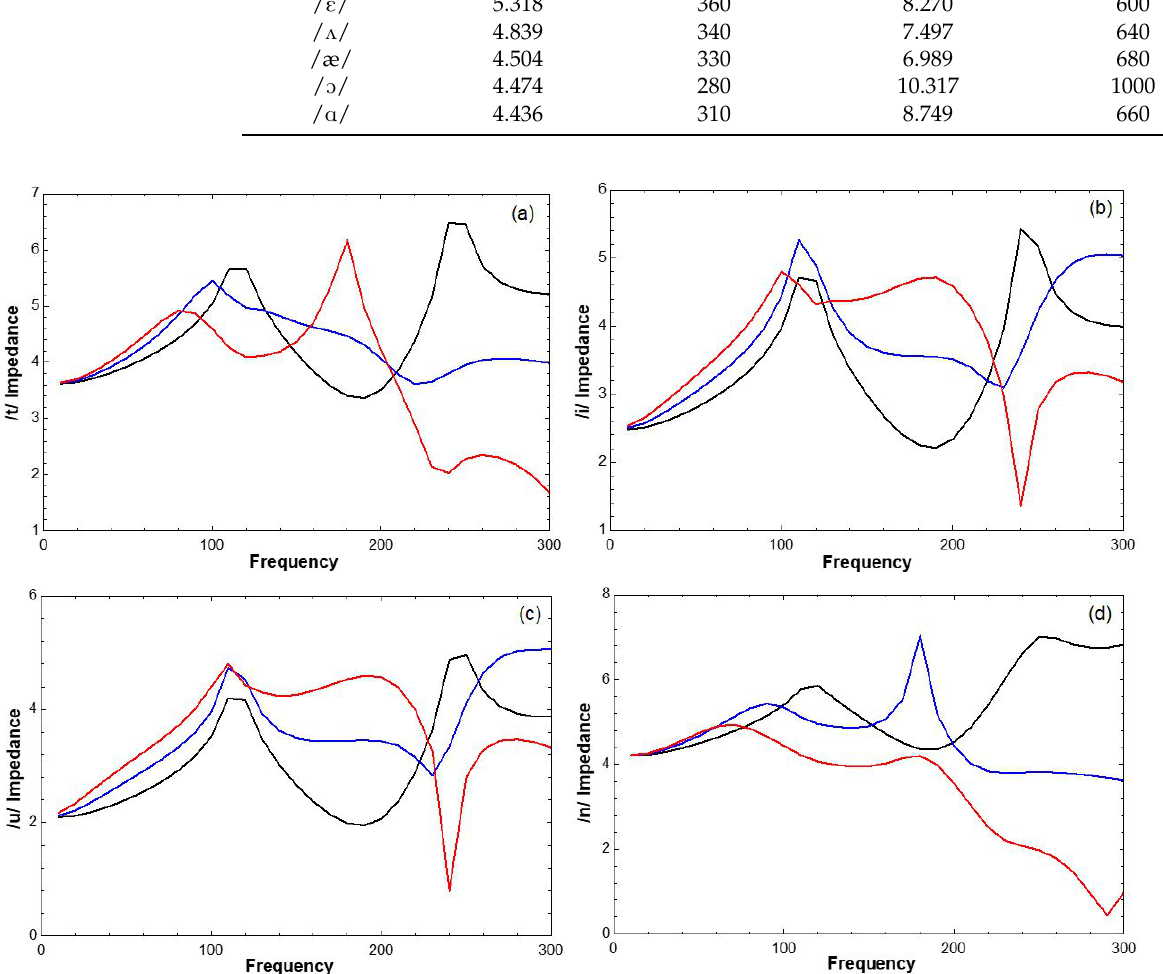
Figure 3. Impedance curves for four vocal tract shapes with three length of straws each with 1 cm 2 cross-sectional area: 0 cm (black), 15 cm (blue), and 30 cm (red). Impedance is in units of dyne-s/cm 5 . ( a ) /t/ ( b ) /i/ ( c ) /u/ ( d )